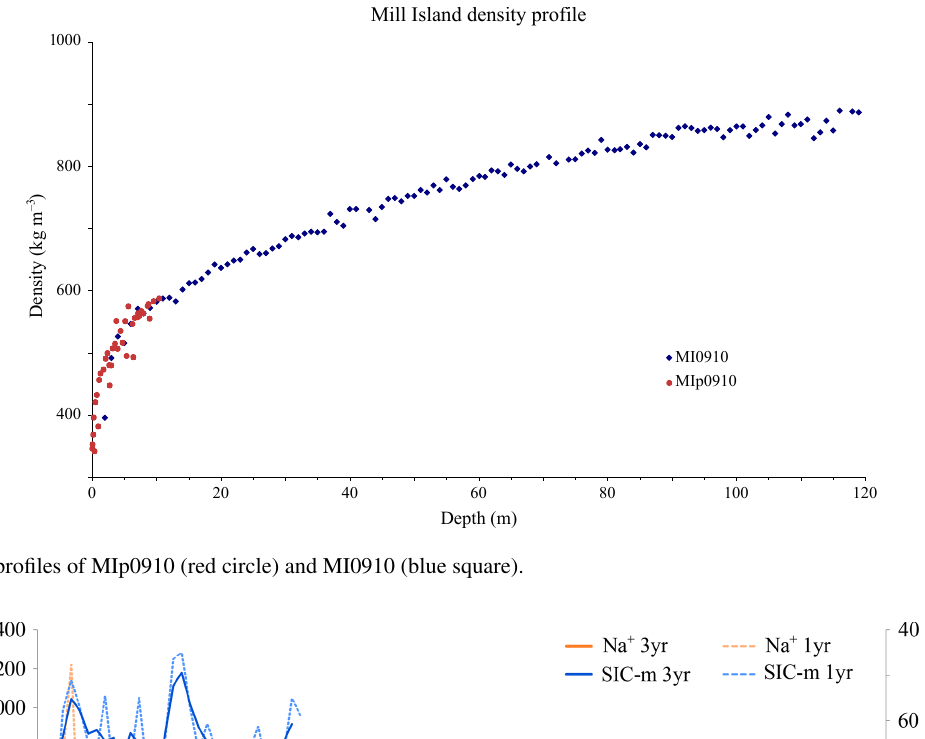
Figure 9. Density profiles of MIp0910 (red circle) and MI0910 (blue square).